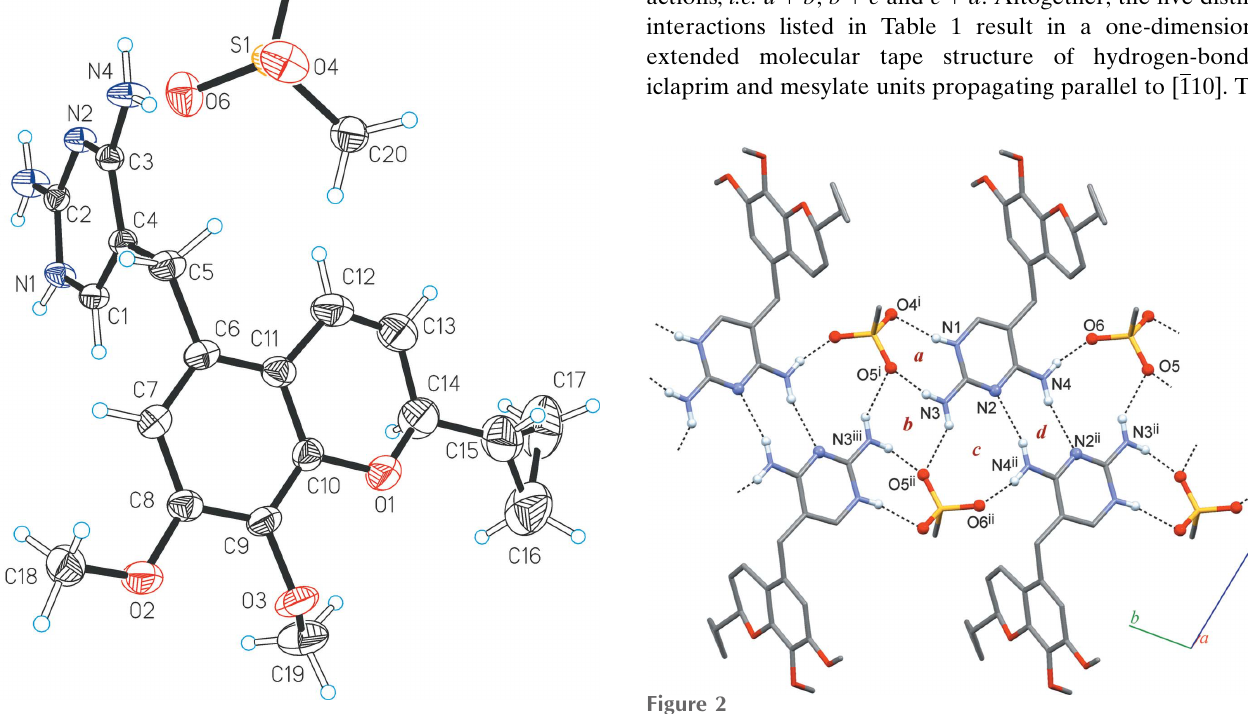
Figure 1 The structures of the molecular entities with displacement ellipsoids drawn at the 50% probability level and hydrogen atoms drawn as spheres of arbitrary